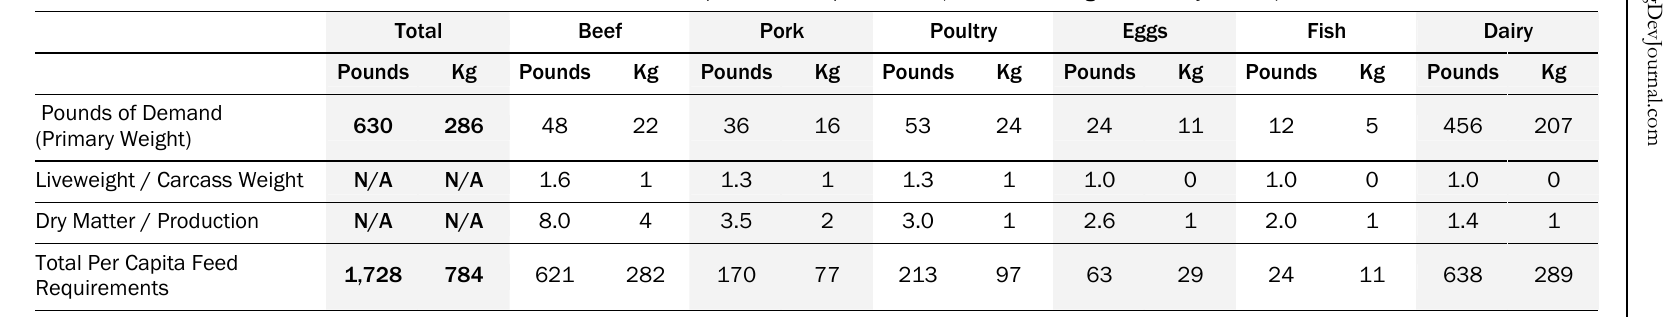
Per Capita Feed Requirements (Pounds or Kilograms of Dry